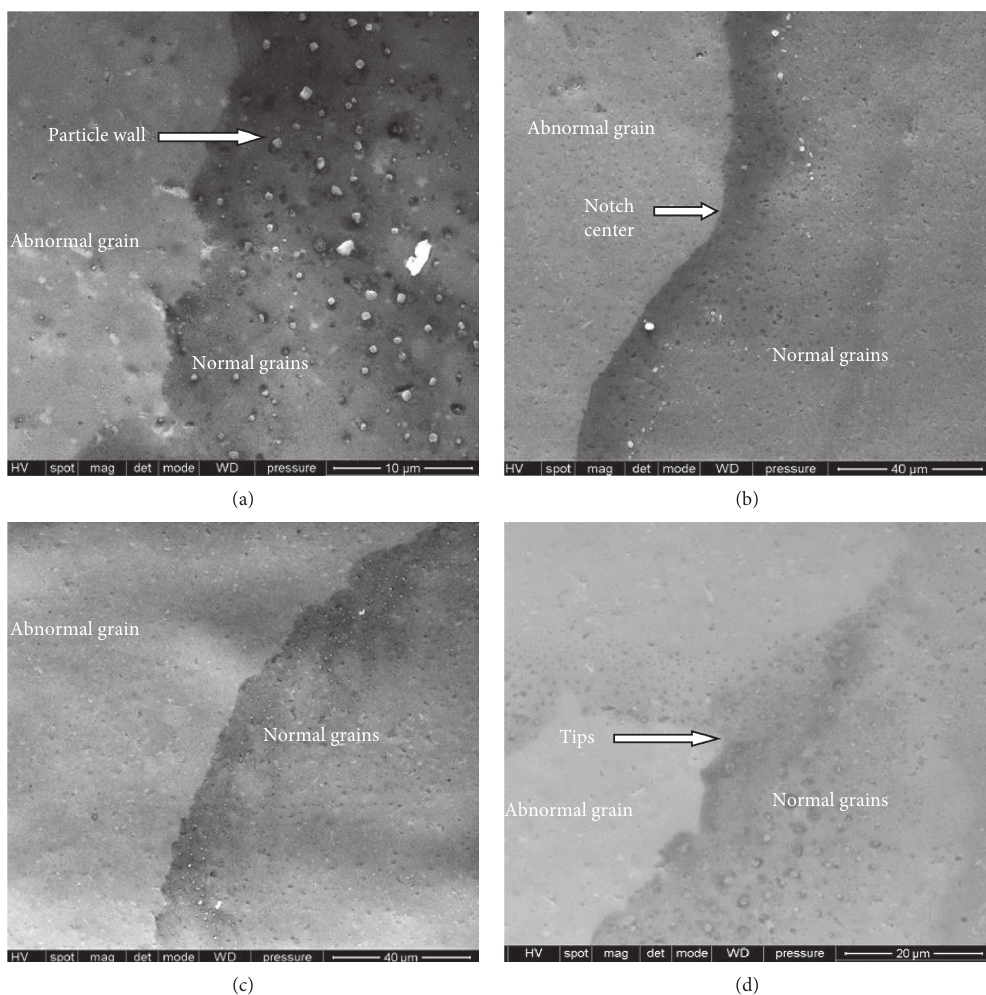
Figure 5: Precipitates at the grain boundaries of the abnormal grain. (a) The wall of particles to resist to GB migration. (b, c) GB bulging at the location with partially dissolved precipitates. (d) GB penetrating the location with high gradient of